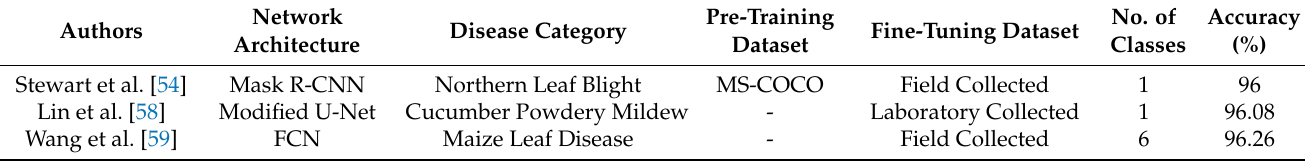
Table 3. Summary of visual segmentation-based models for monitoring plant